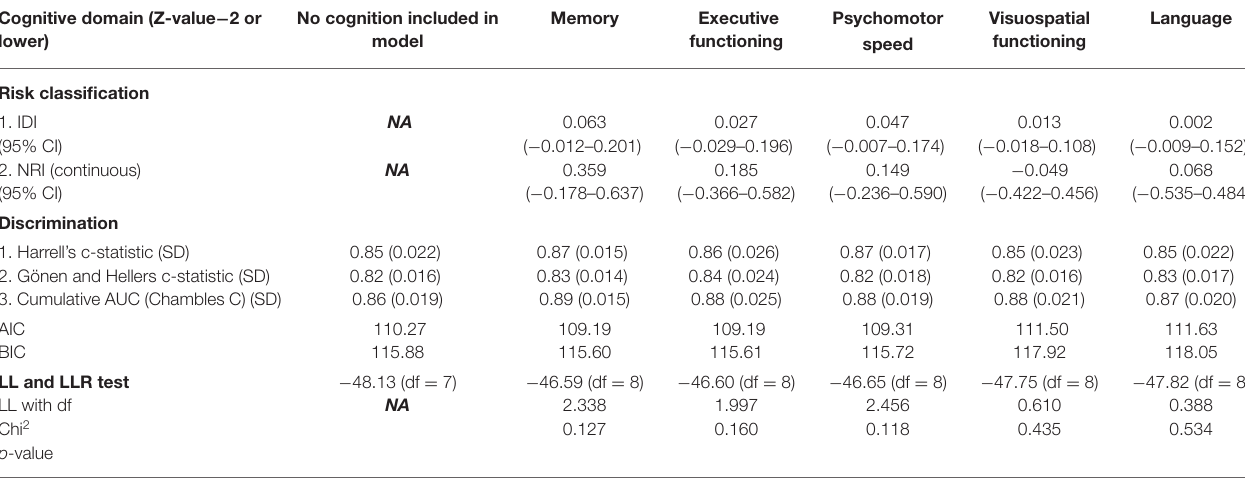
TABLE 4 | Mean added prognostic value for each cognitive domain in low-grade glioma. Cognitive domain (Z-value − 2 or